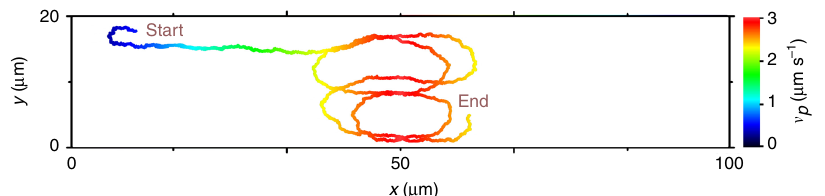
Fig. 9 Numerically calculated trajectory of an AP in a static intensity pro fi le. Example of a numerical trajectory in a static triangular velocity pro fi le (same pro fi le as in Fig. 1) with v p labeled in